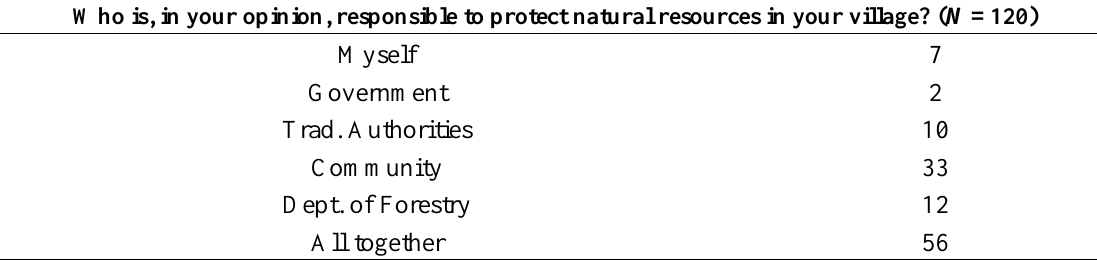
Table 2. Percieved responsibilities for natural resource